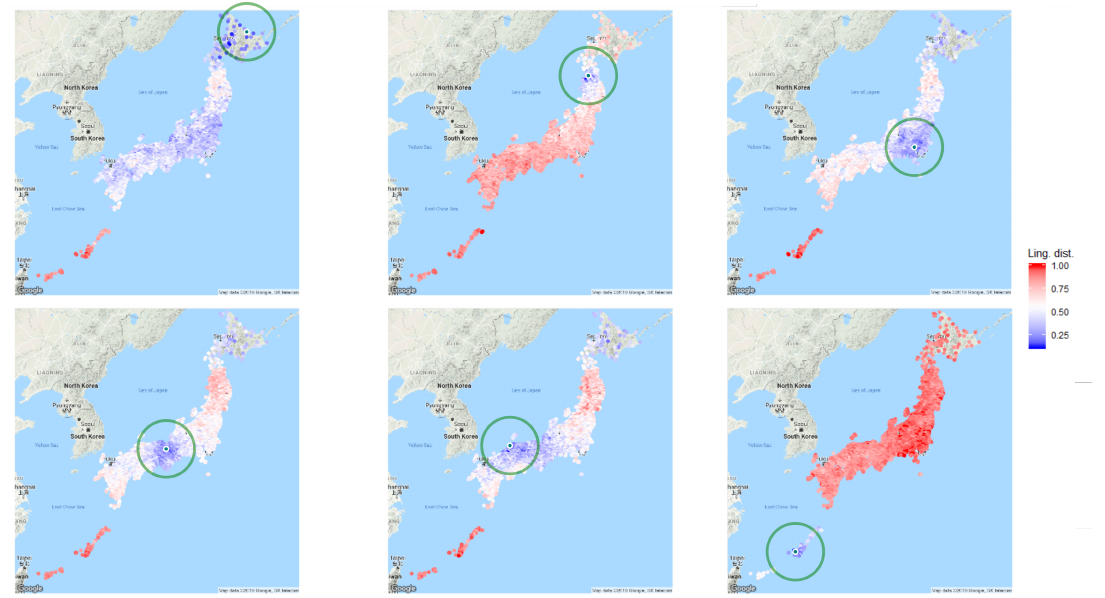
Figure 7. Linguistic distances map with six reference sites from top left to bottom right: Northern Hokkaido, rural location in Aomori prefecture, Tokyo, Kyoto, Matsue city (Shimane prefecture) and Naha, capital of Okinawa